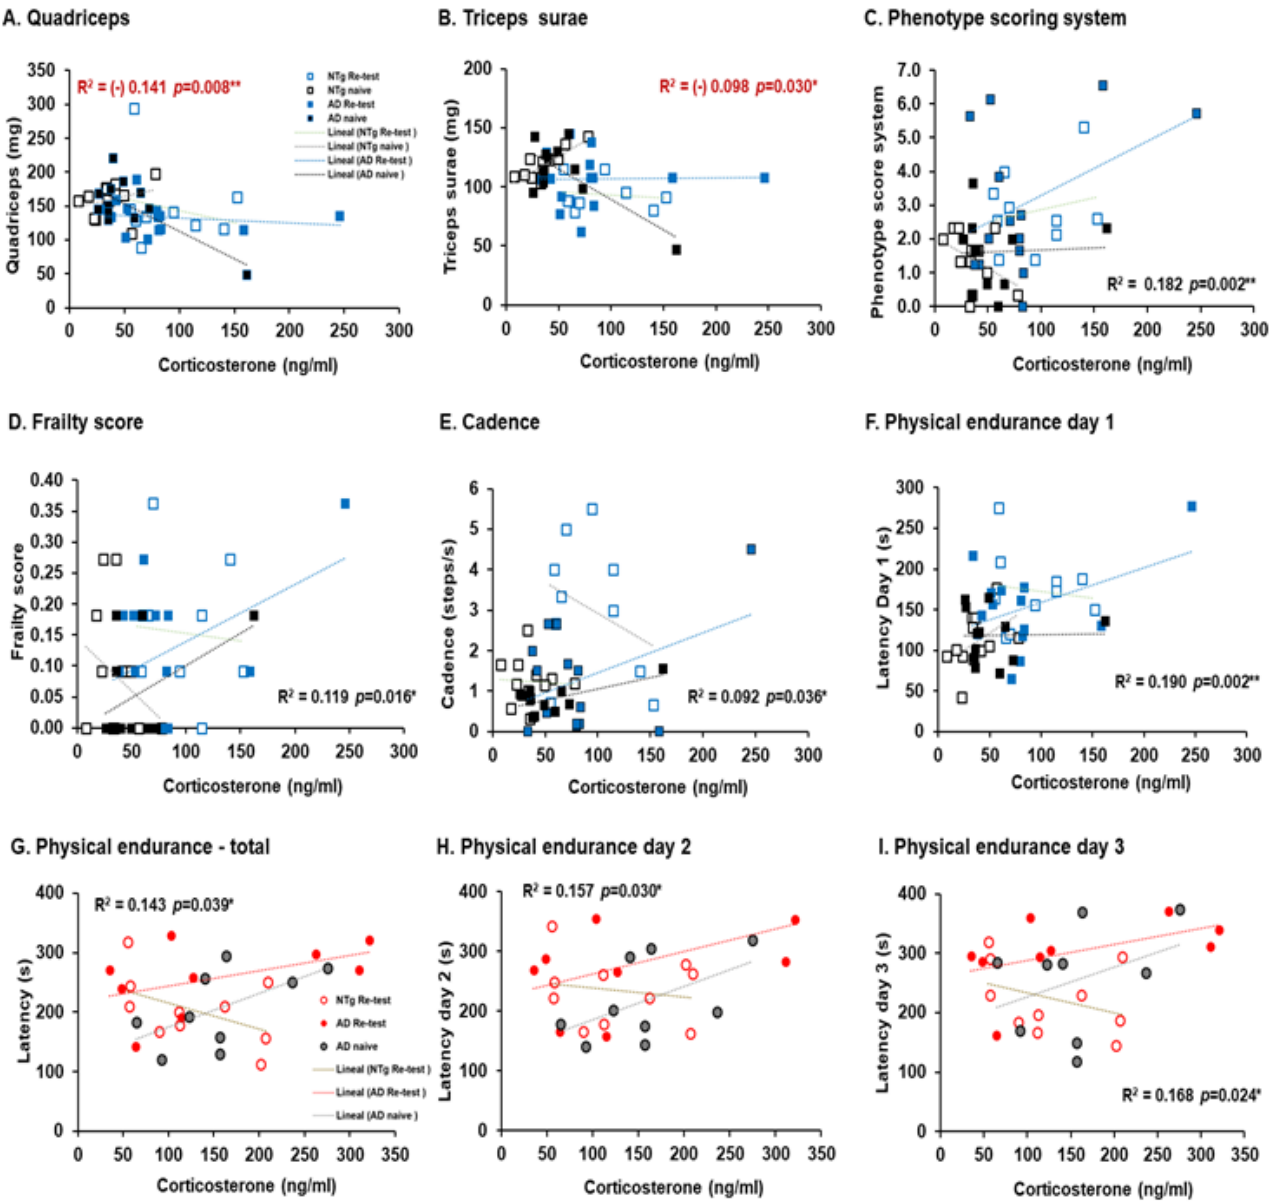
Figure 8. Functional corticosterone correlations in males and females. Pearson’s Correlations anal- ysis of corticosterone in males and females. Meaningful, Pearson’s correlation in males between corticosterone and ( A ) quadriceps, ( B ) triceps surae, ( C ) phenotype scoring system, ( D ) frailty score, ( E ) cadence, and ( F ) physical endurance Day 1. Meaningful, Pearson’s correlation in females be- tween corticosterone and ( G ) physical endurance—total, ( H ) physical endurance Day 2, ( I ) physical endurance Day 3. Statistics: Pearson r 2 , ** p < 0.01, * p < 0.05.